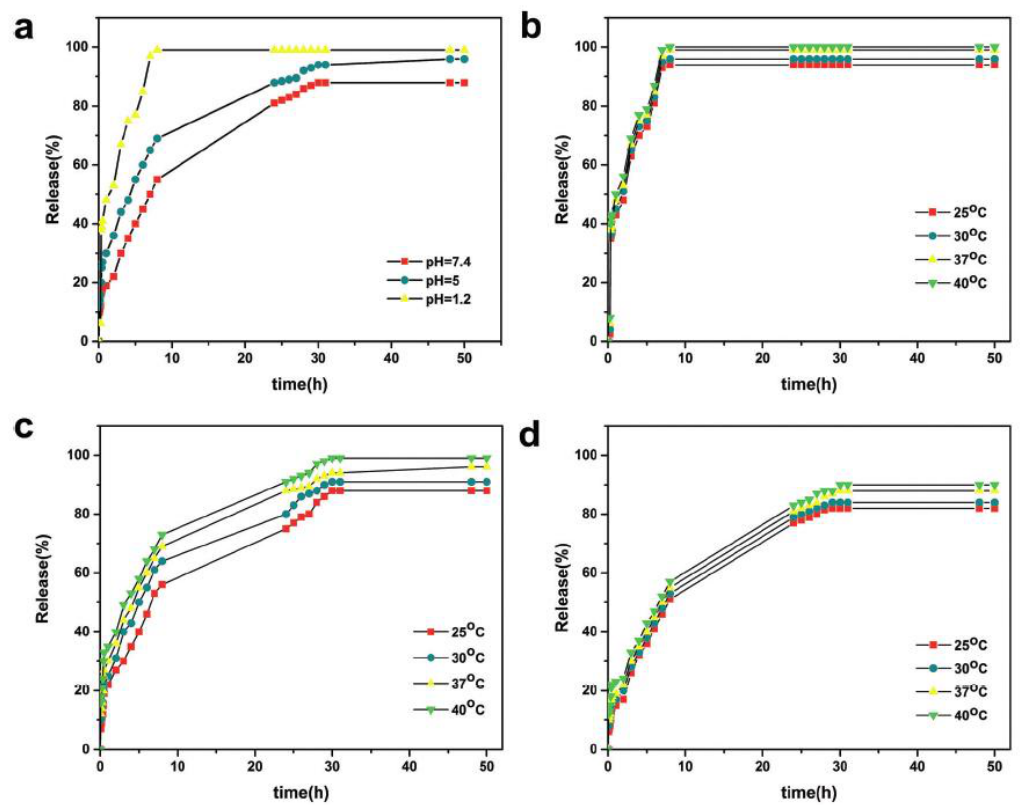
Figure 7. ( a ) The release of cephalexin at different pH at T = 37 °C, ( b ) the effect of temperature on the release of cephalexin at pH = 1.2, ( c ) the effect of temperature on the release of cephalexin at pH = 7 and ( d ) the effect of temperature on the release of cephalexin at pH = 5. Reproduced from Reference [24] from the Royal Society of Chemistry, copyright 2018.